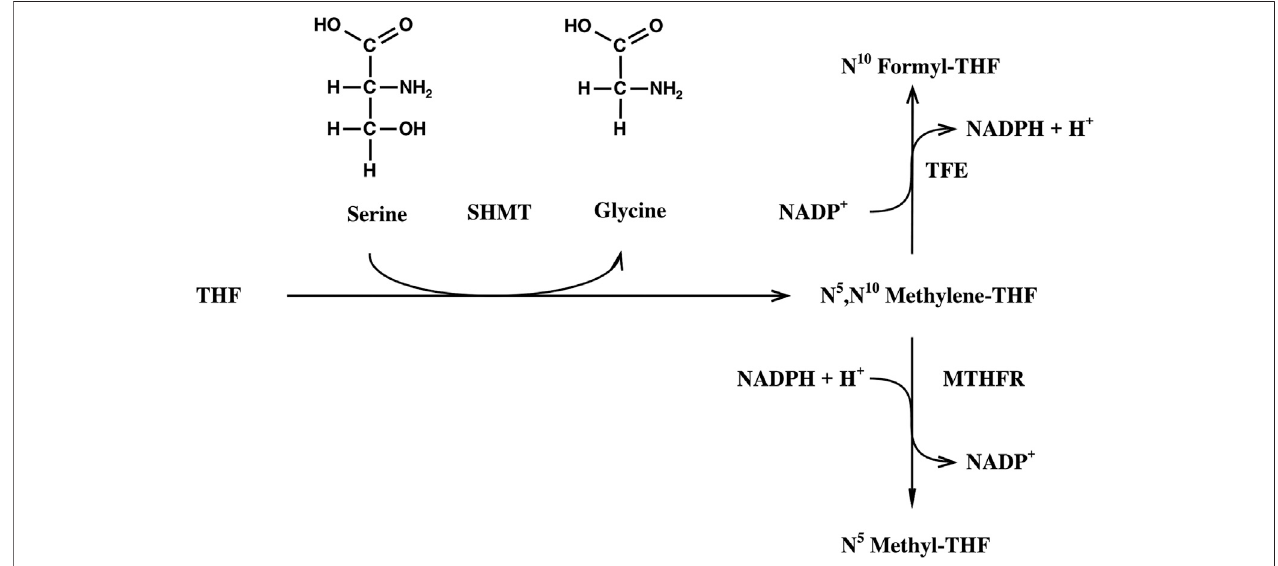
FIGURE 2 | Alternative reaction assays for the determination of the kinetic isotope effect on the SHMT reaction. THF, tetrahydofolic acid; SHMT, serine hydroxymethyltransferase; TFE, trifunctional enzyme; MTHR, methylene THF reductase.